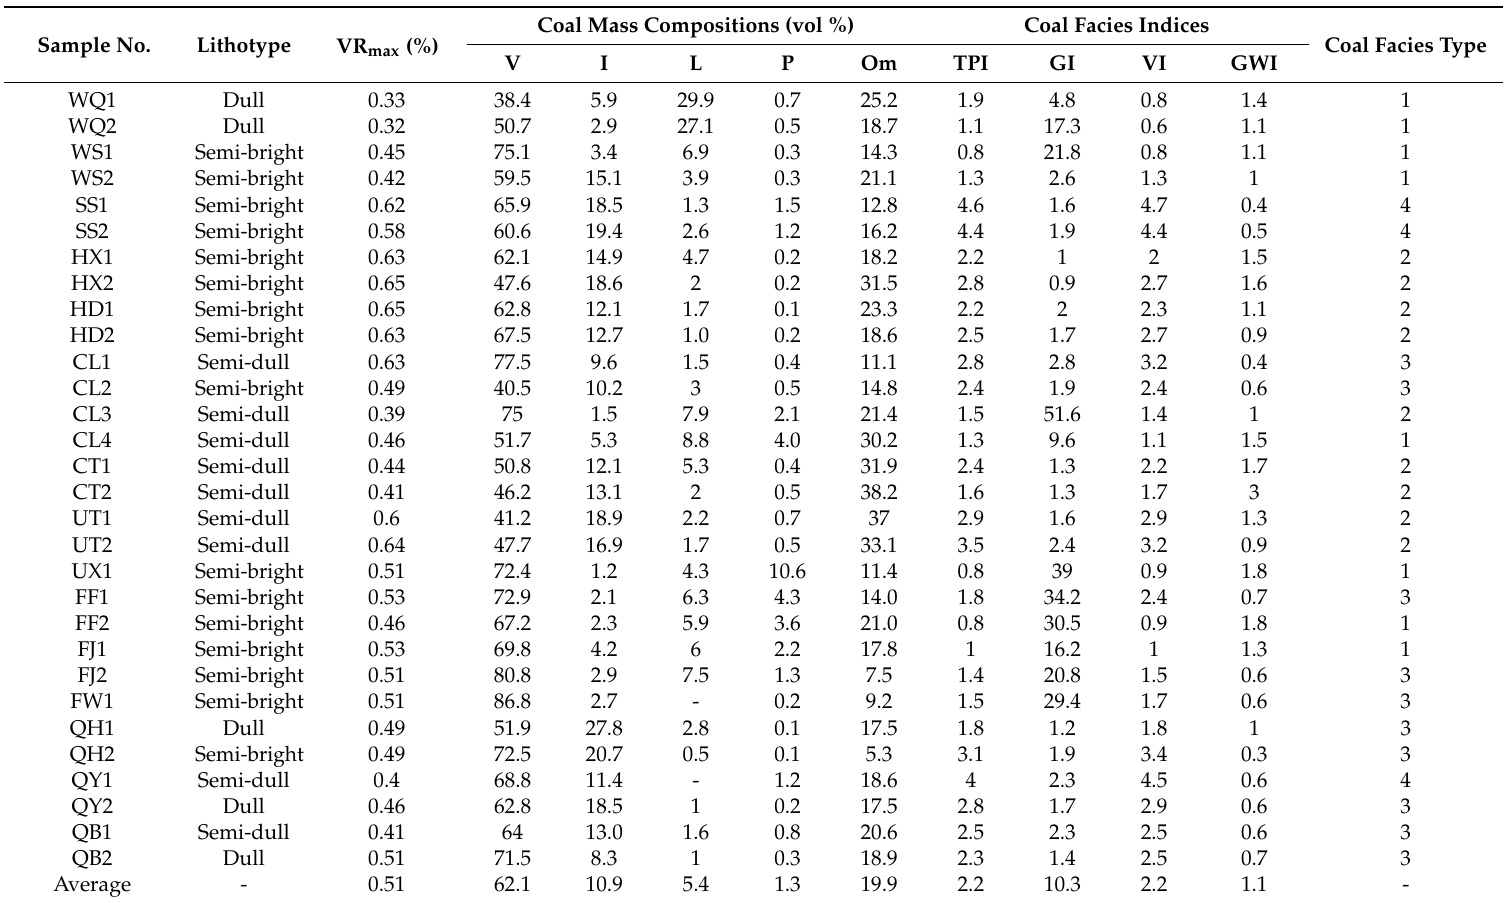
Table 2. The coal mass compositions, maximum reflectance of vitrinite and coal facies indices (tissue preservation index (TPI), gelification index (GI), vegetation index (VI), and ground water index